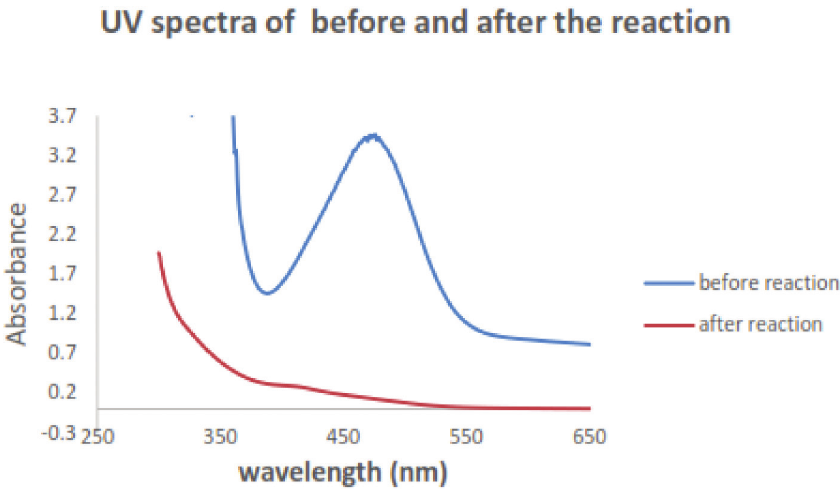
Figure 3: (a) UV-vis spectra of guar gum. (b) UV absorption peak of initial mixture before the reaction. (c) The formation of palladium nanoparticles, the peak at 470 nm gradually disappear after the reaction.